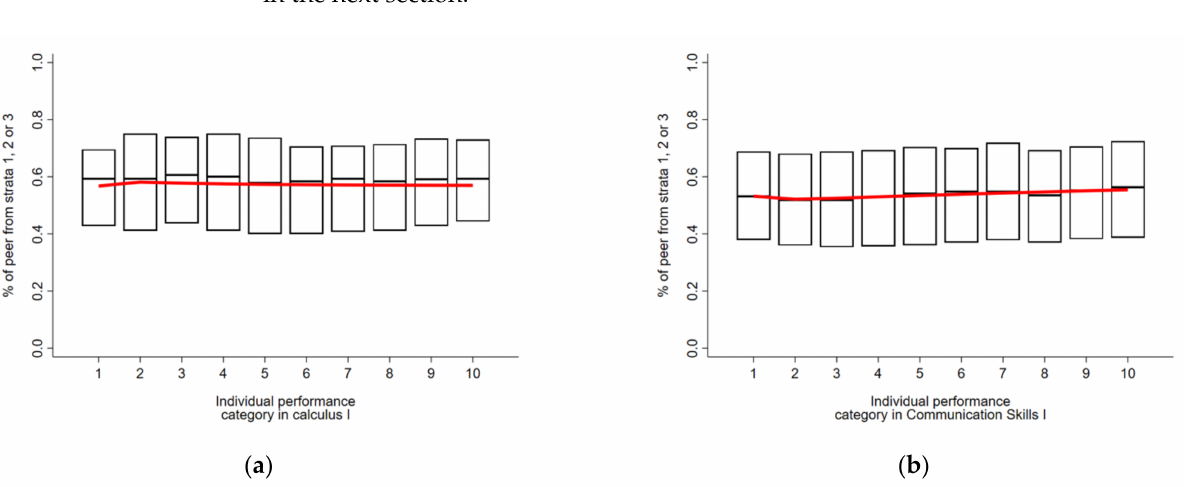
Figure 3. Peer percentage distribution in lower stratum by student performance category: ( a ) Calculus I; ( b ) Communication Skills I. Source: Authors’